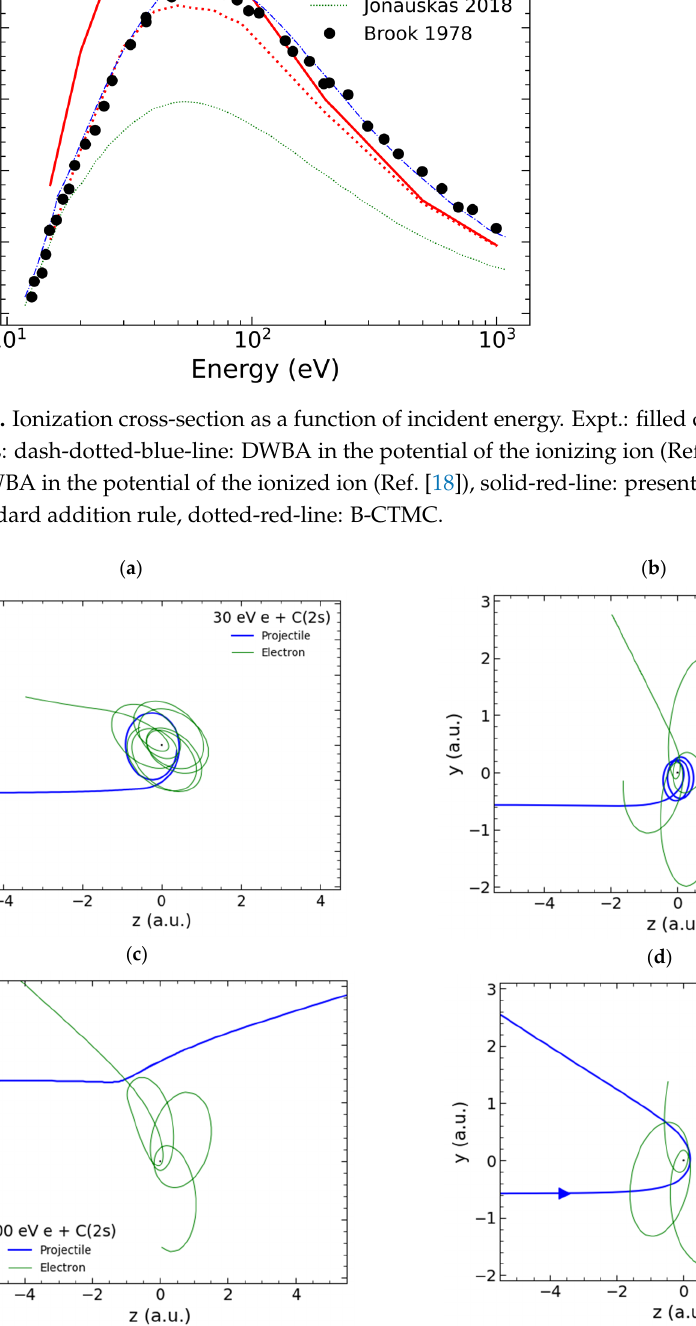
Figure 5. Classical trajectories in electron-carbon collisions. ( a , b ) correspond to exchange events between the projectile and 2s and 2p electrons, respectively. ( c , d ) correspond to ionization events and show trajectories of the projectile and electrons emitted from the 2s and 2p orbitals.